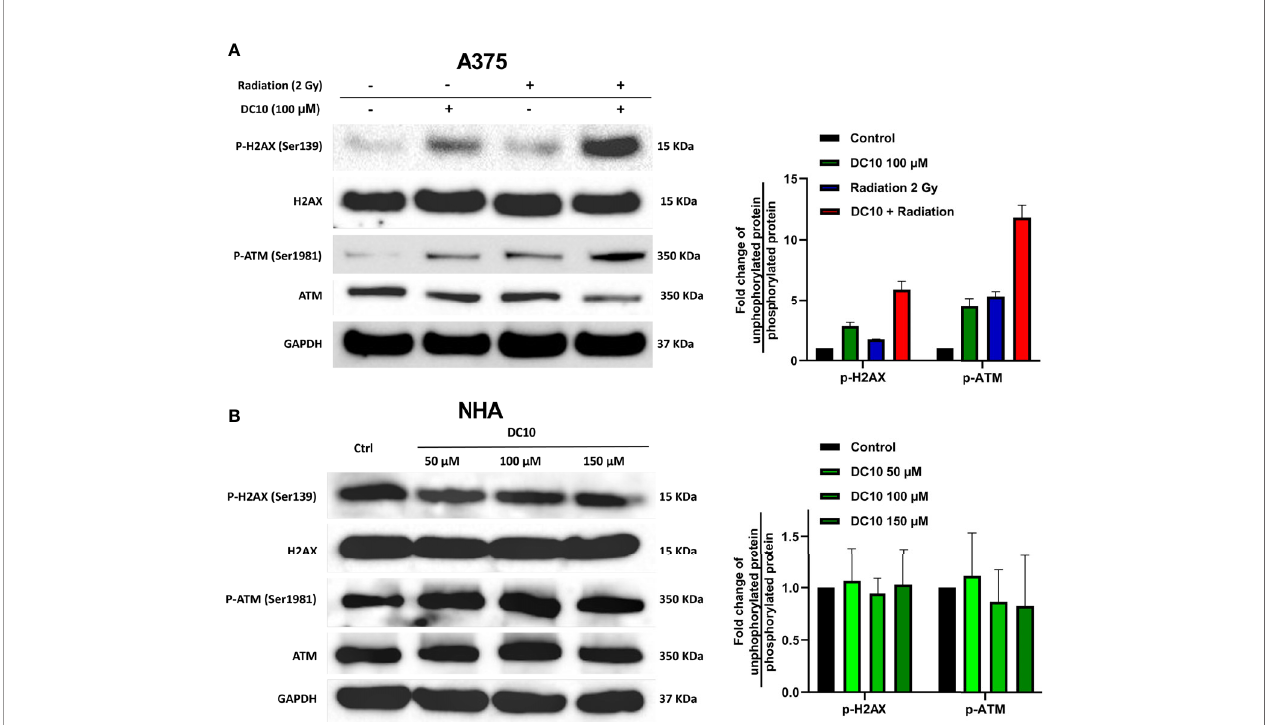
FIGURE 3 | Synergistic effect of DC10 and radiation on DNA damage. Immunoblotting for unphosphorylated and phosphorylated forms of ATM and H2AX and GAPDH as a loading control in (A) A375 cells treated with DC10 and/or radiation and (B) NHA cells treated with DC10 as indicated. Ratios between phosphorylated and unphosphorylated forms expressed as fold change compared to untreated controls (right